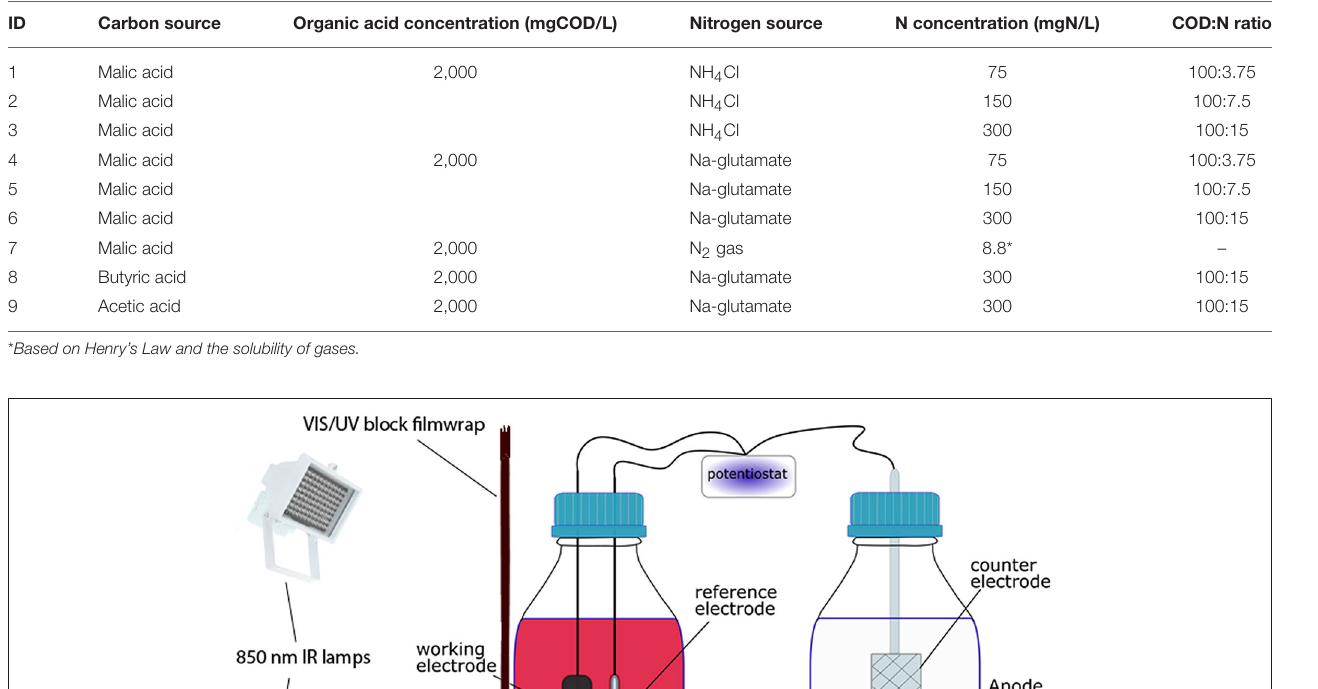
cells were flushed with argon for 20 min. Subsequently, the cells were closed with butyl septa and capped with GL45 Duran